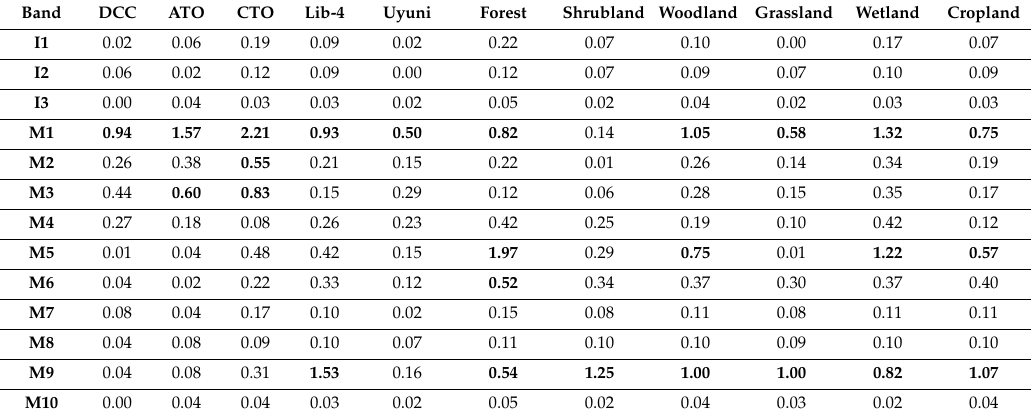
Table 6. S-NPP VIIRS NG RSR Earth-reflected scene-dependent γ for measured 1% extended bandpass limits, shown in %.